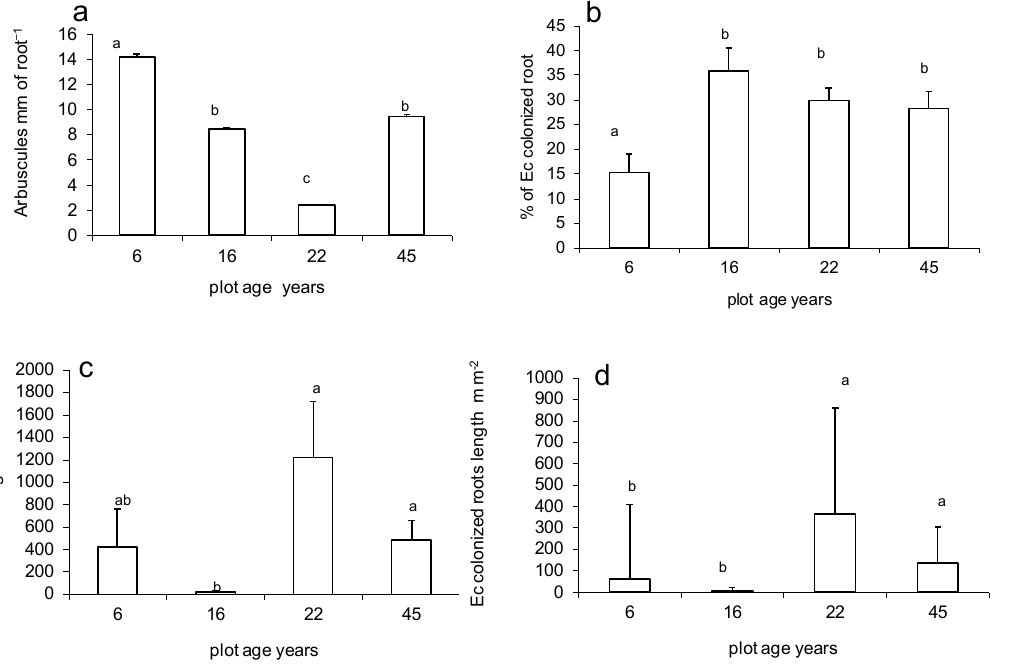
Figure 4. Number of arbuscules in 1 cm sections of roots of Plantago laceolata sown in 6-, 16-, 22-, and 45-year-old spontaneously developing post-mining sites in the Sokolov coal mining area ( a ); percentage of root length of fine woody roots colonized by ectomycorrhizal (Ec) fungi in the same sites ( b ); length of fine woody roots in the same sites in spring 2007 ( c ); length of fine woody roots colonized by EcM fungi in the same sites ( d ). Statistically homogeneous groups are marked by the same letter (one-way ANOVA, LSD post hoc test p < 0.05).